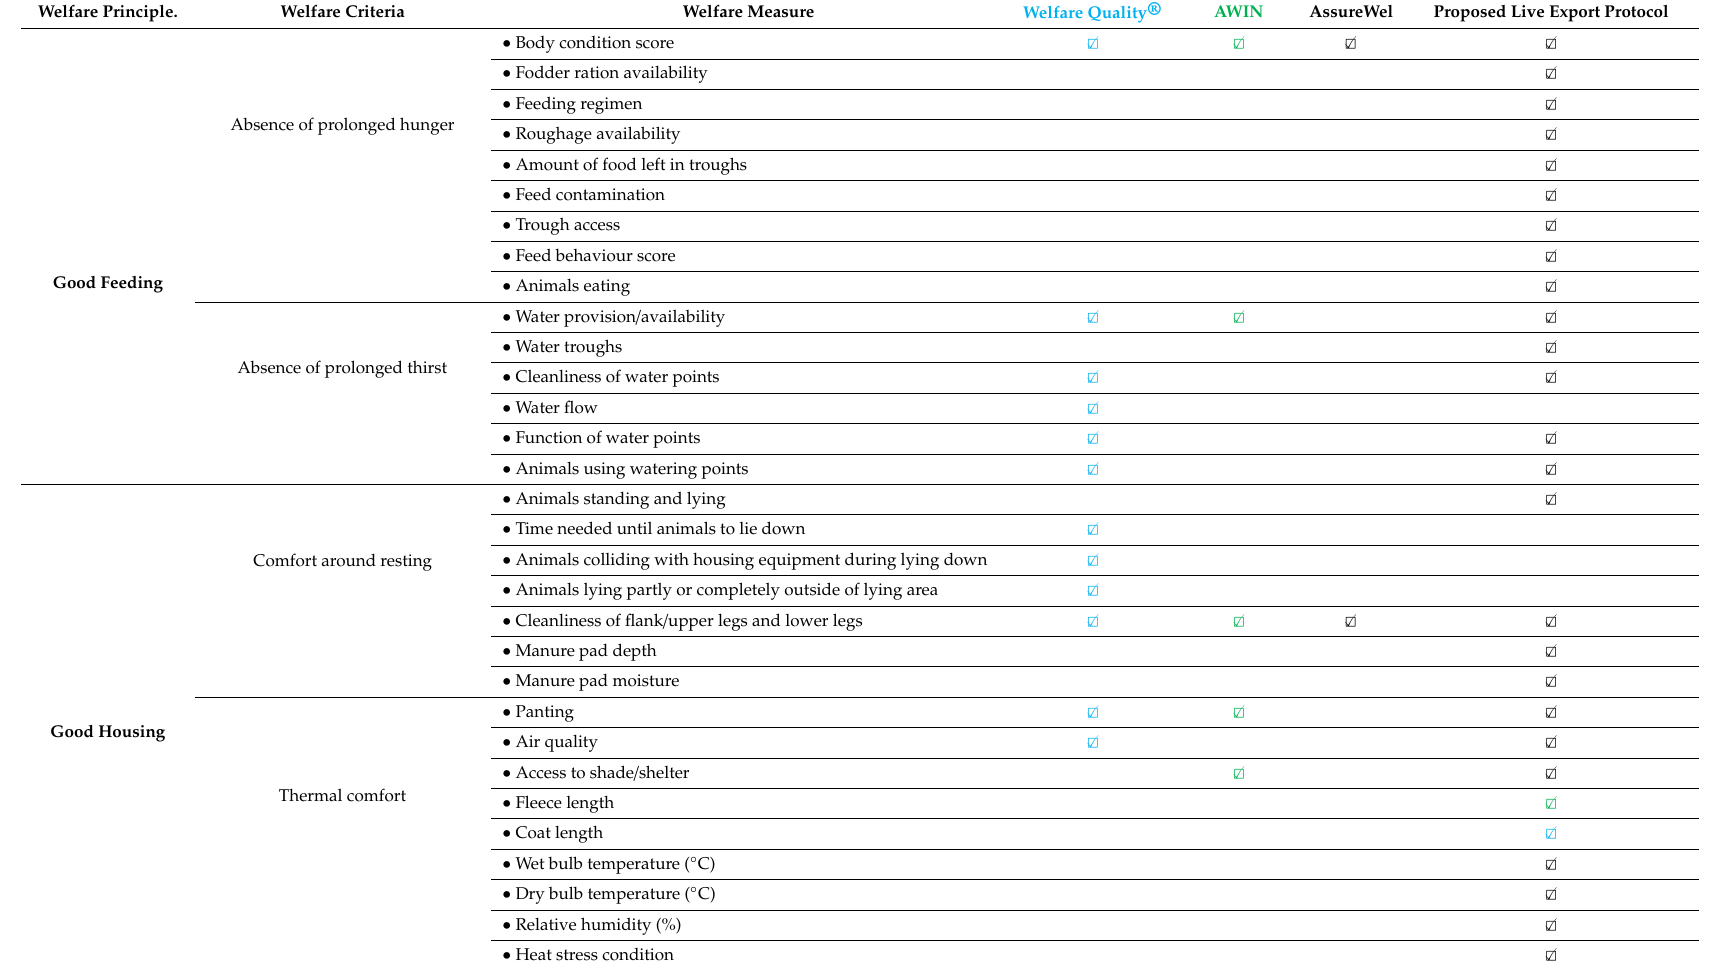
Table 1. Welfare measures from existing protocols for cattle and sheep, and for the proposed Australian livestock export protocol. Colour indicates measures that are species specific; blue—cattle only measures, green—sheep only measures, and black—applicable to both species. Welfare